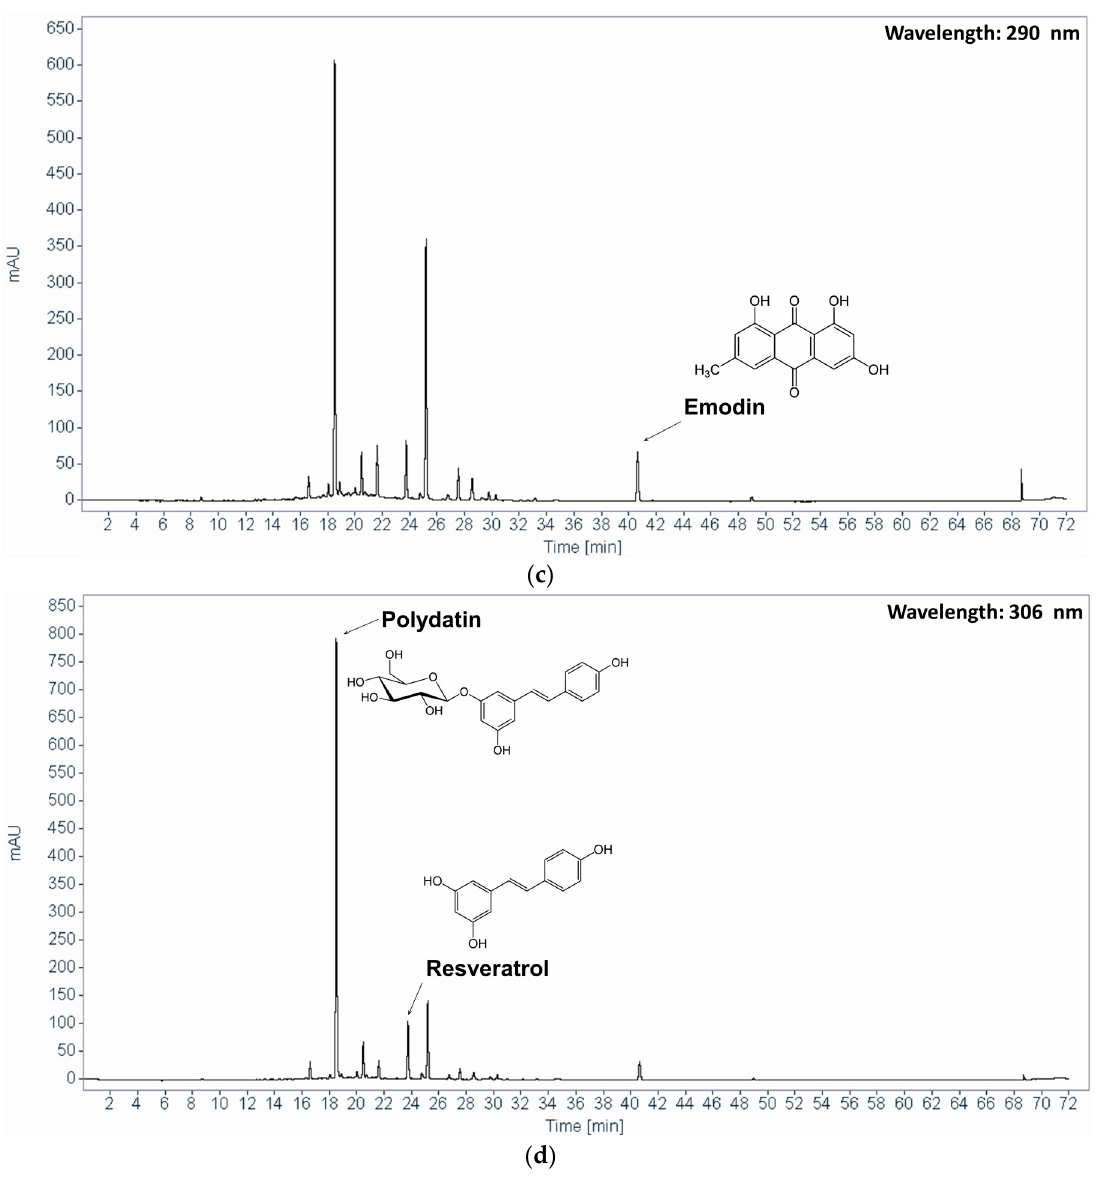
Figure 1. Chromatograms of ( a ) standard mixture at 290 nm, ( b ) standard mixture at 306 nm, ( c ) PCE at 290 nm, ( d ) PCE at 306 nm. PCE, P. cuspidatum extract.